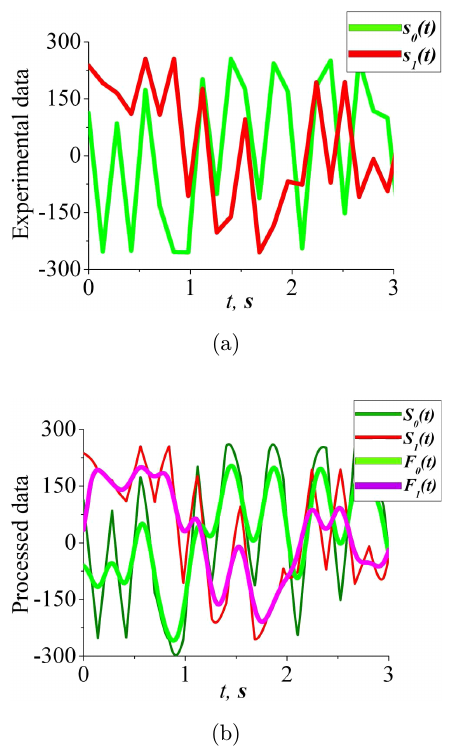
Fig. 2. Original signals (a) and results of data preprocessing